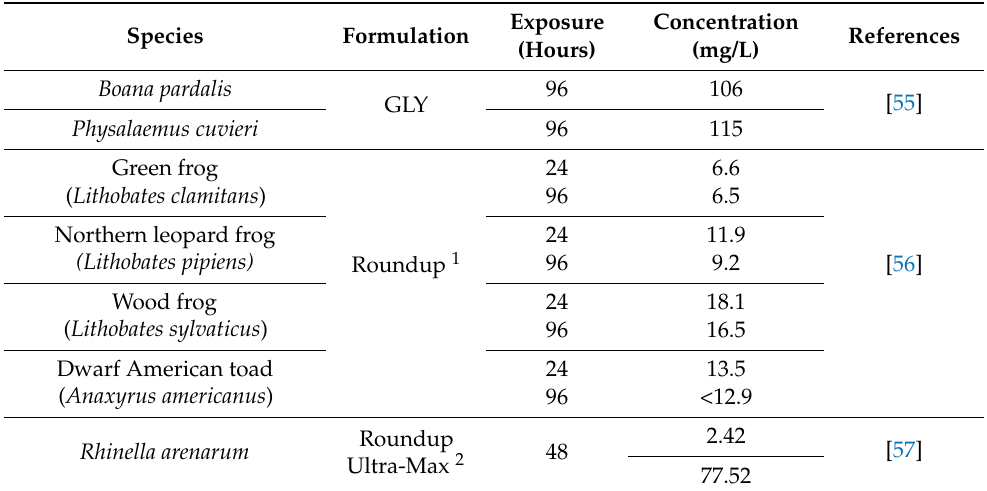
Table 2. Acute toxicity values (LC50) of glyphosate and its commercial products on amphibians. Species Formulation